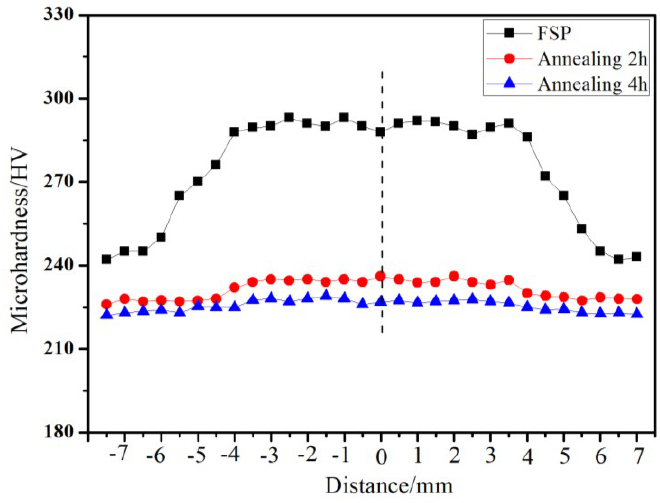
Figure 5. Microhardness variations as a function of distance from center line for FSP NAB alloy and post heat treated